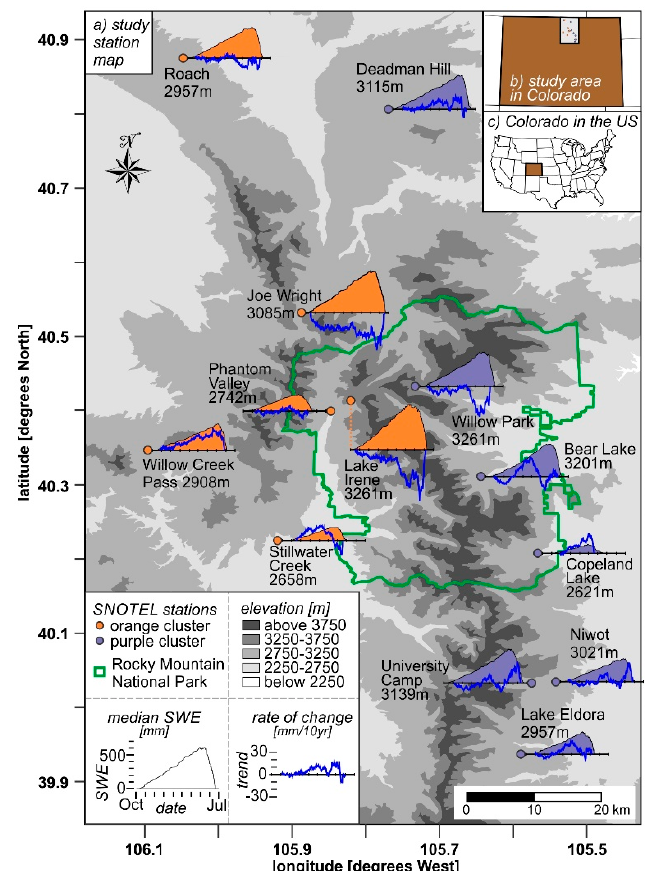
Figure 1. Location of ( a ) the 13 SNOTEL data collection stations ( b ) within the Northern Front Range of the state of Colorado ( c ) in the Western United States. The median niveograph and the daily SWE trend of each station over the period of record is presented in ( a ), scaled according to the legend. The SNOTEL orange and purple stations refer to those on the western and eastern side of Rocky Mountain National Park, as used by Clow [20] and Fassnacht et al. [17].